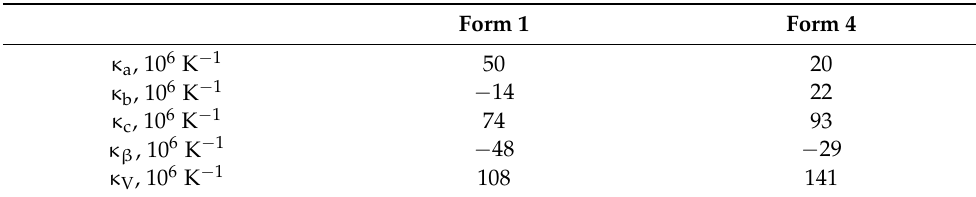
Table 3. Comparison of linear and volumetric thermal expansion coefficients, calculated in the 25–125 ◦ C range, using the formula x 125 = x 25 (1 + 100 κ x ), with x = a, b, c, β , V.